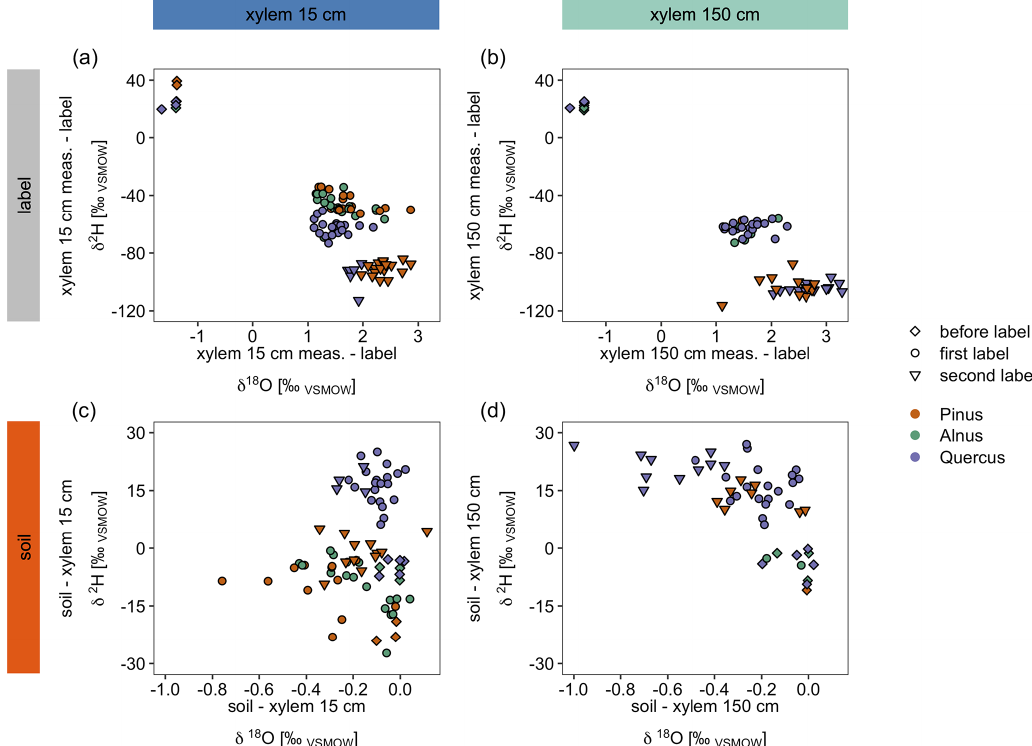
Figure 7. Panels (a) and (b) show differences between daily median in situ stable water isotope measurements and the label water’s stable water isotope signature presented in a dual isotope plot. Panels (c) and (d) compare daily median in situ soil measurements (averaged over both soil depths) with the corresponding xylem measurements of the same day. Note that the points “before label” refer to the average value between pre-event precipitation and pre-event irrigation water, while first label and second label refer to the isotopic signal of the label water. See Table 2 for the isotopic